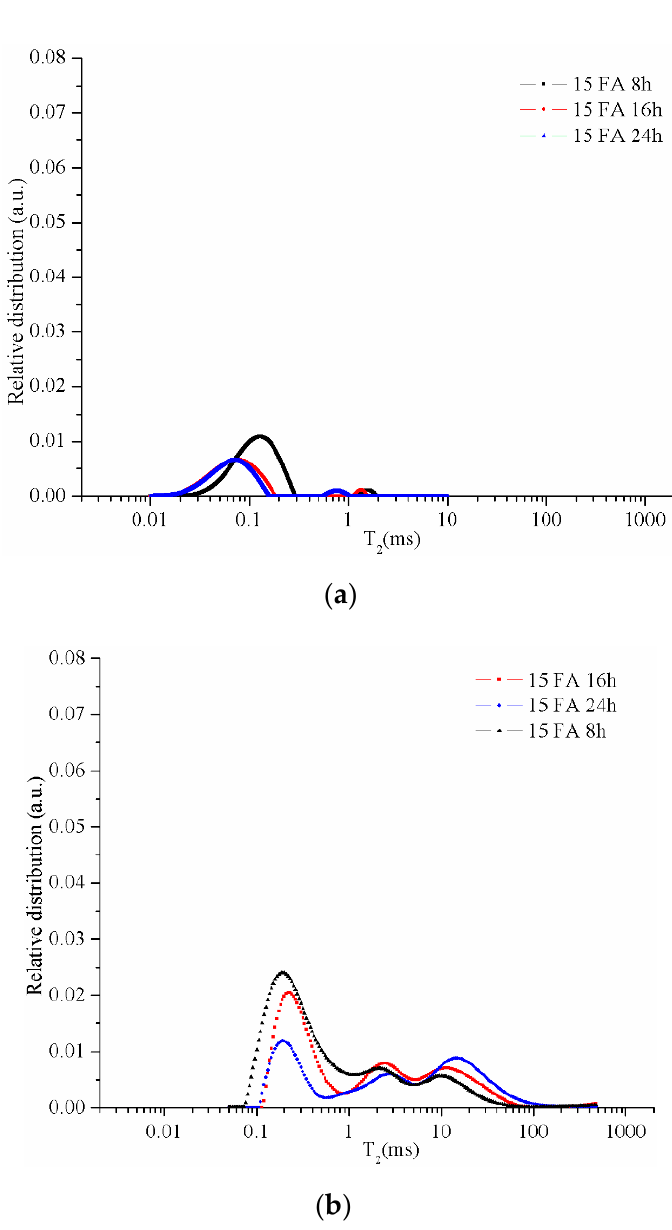
Figure 9. Relative pore size distribution in sample 15 FA dried for 8, 16, or 24 h: ( a ) after 48 days of activation and ( b ) after 7 days of immersion in water.